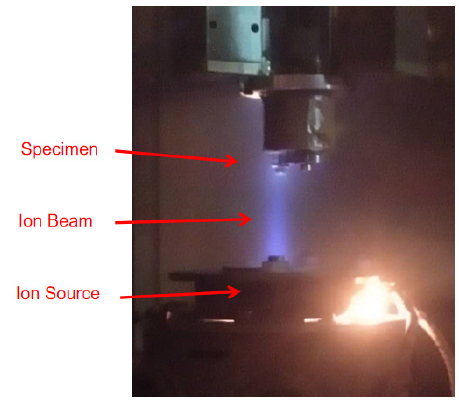
Figure 5. Sample #3 in IBF processing. Table 7. IBF parameters (#3).